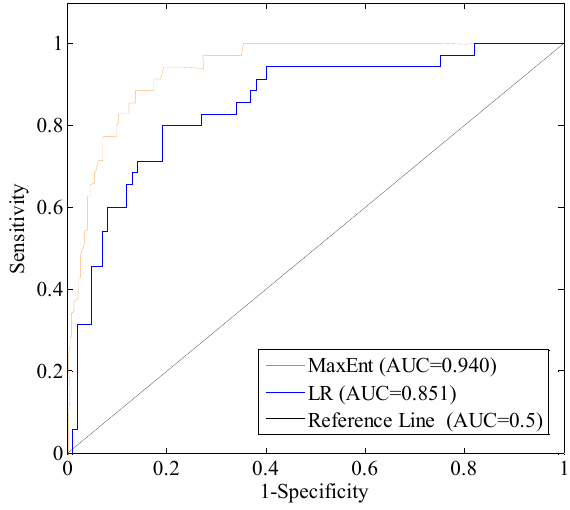
Figure 8. ROC curves of the models.